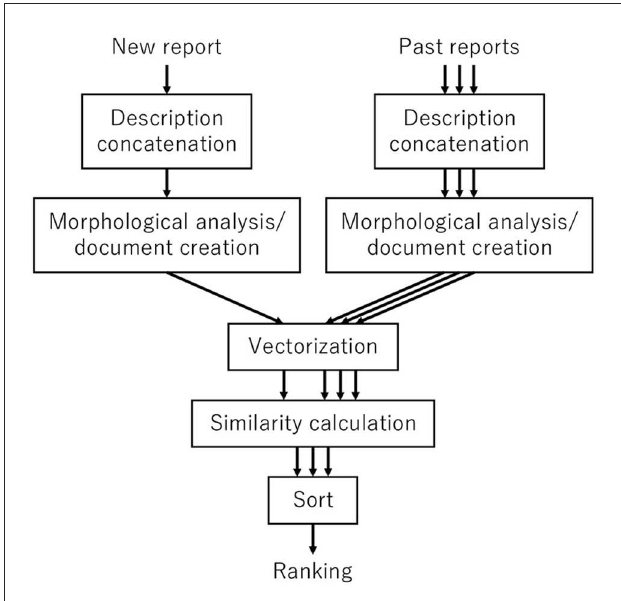
FIGURE9 Steps to detect duplicate reports in the baseline systems.